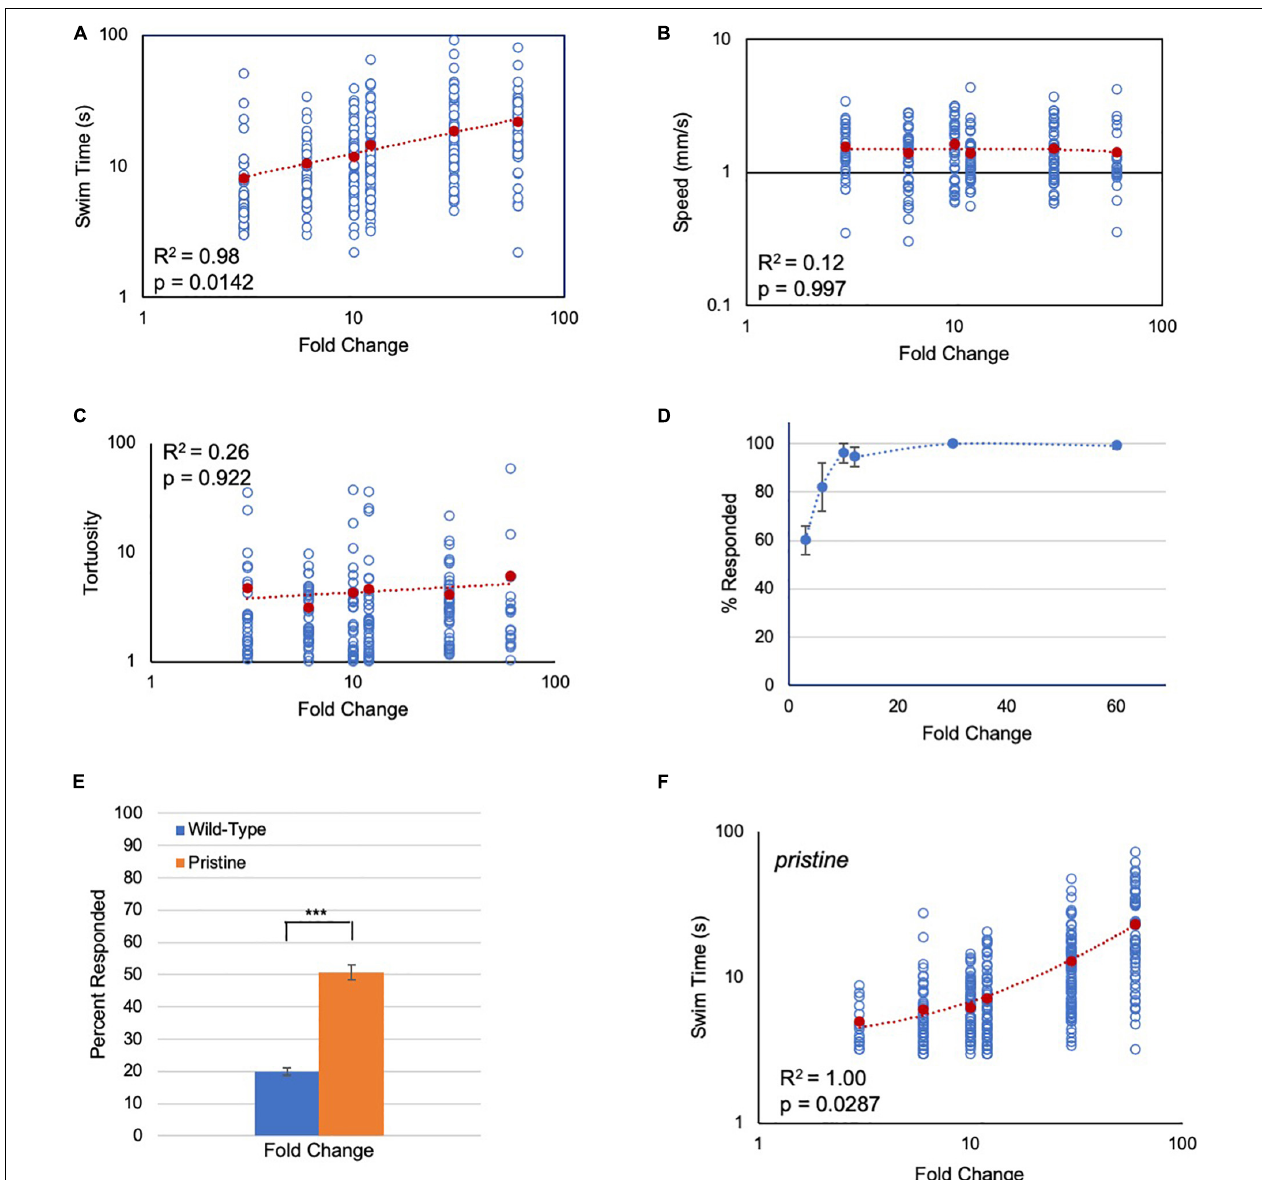
FIGURE 2 | Response of Ciona larvae to fold change light dims. (A) Larval swim times increase as a power function in response to increased fold change light dimming (3-fold to 60-fold; log/log plot shown). All data points (blue circles) and averages (red circles) are shown [same for panels (B,C,F) ]. See Movie 1 for representative results. (B) Swim speed is constant across fold change dimming series (log/log plot shown). (C) Swim tortuosity is constant across fold change dimming series (log/log plot shown). (D) The percent of larvae responding as a function of fold change dimming. Shown in graph are the averages from three recordings (+ S.D.). (E) Percent of larvae responding to a six-fold dim at low illumination conditions (30 lux to 5 lux). n = 76 and 131, for wild-type and pristine , respectively (*** = p < 0.001; Wilcoxon Rank-Sum test). (F) Larval swim times of homozygous pristine mutants increase as a linear function in response to increased fold change light dimming (3-fold to 60-fold; log/log plot shown). See Supplementary Figure 1 for sample sizes, average values, and statistical analyses. All larvae were observed for 2 min after dimming. The p -values shown were determined from a Kruskal-Wallis